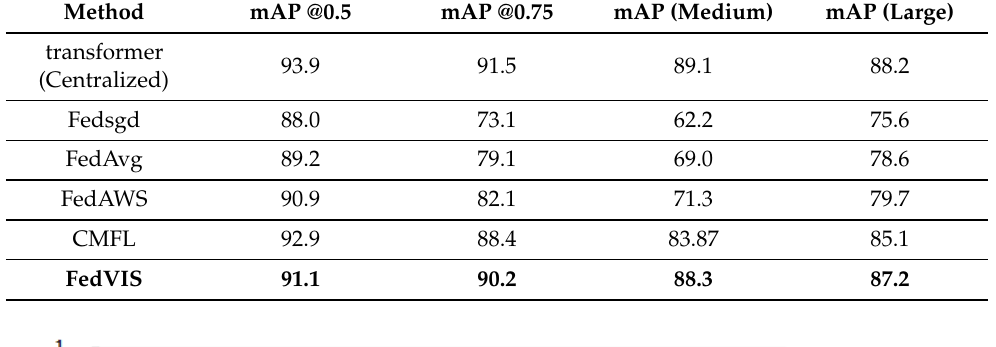
Table 1. Test results of different methods on MSCOCO dataset, using the coco dataset to preliminary test the model. The results are evaluated using the mAP at different IoU thresholds. Compared to other federated learning algorithms, FedVIS has the best performance.